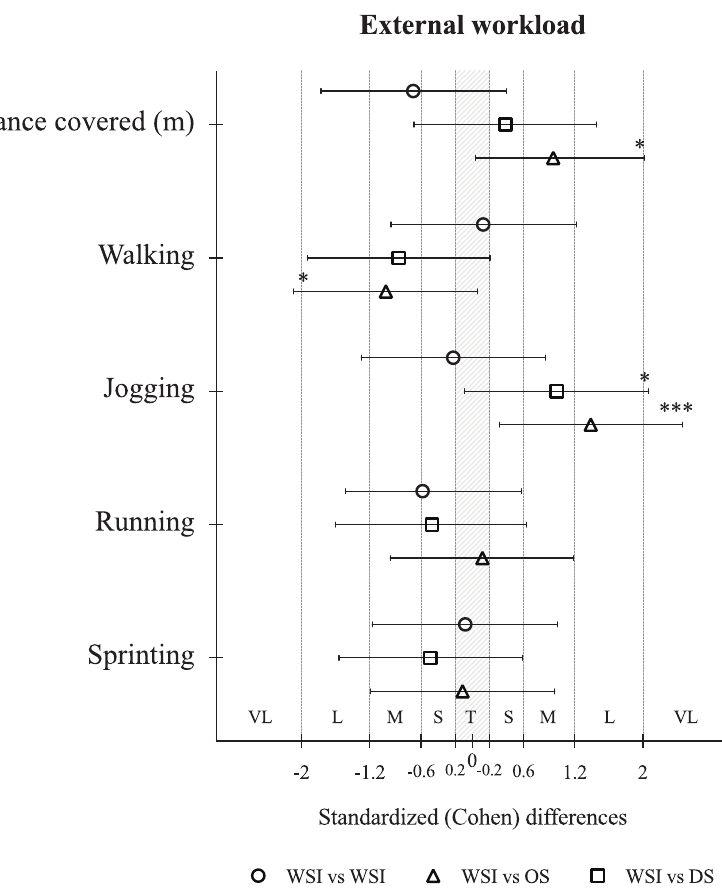
FIGURE 3 Standardized (Cohen) diff erences in external workload variables according to the game scenarios’ comparisons. Error bars indicate uncertainty in the true mean changes with 90% confi dence intervals. Asterisks indicate the likelihood for the magnitude of the true diff erences in mean as follows: *likely; ***most